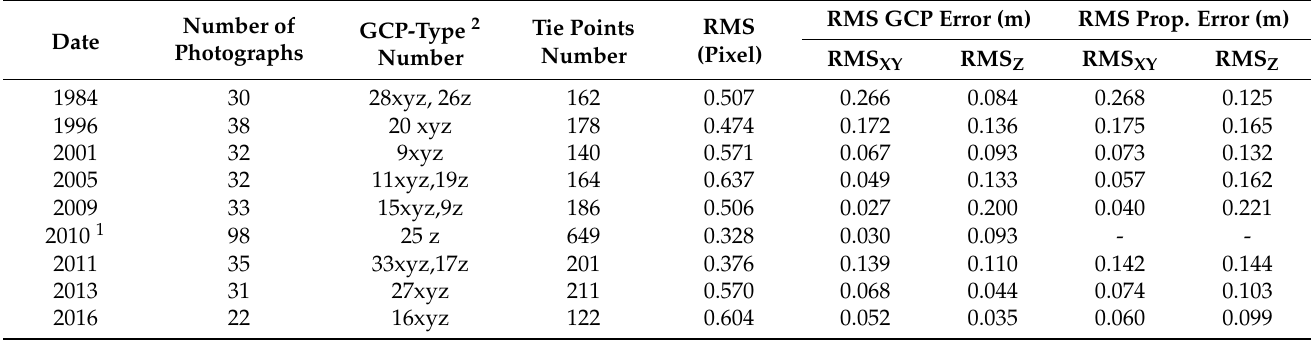
Table 2. Orientation